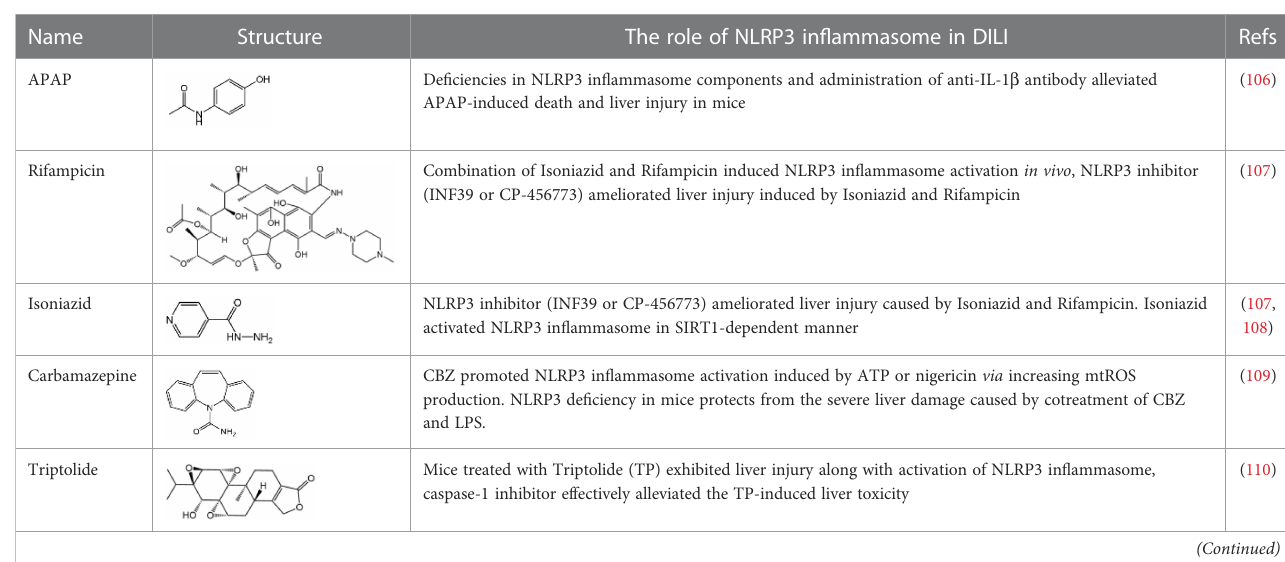
TABLE 1 The role of NLRP3 in fl ammasome in Drug-Induced Liver Injury